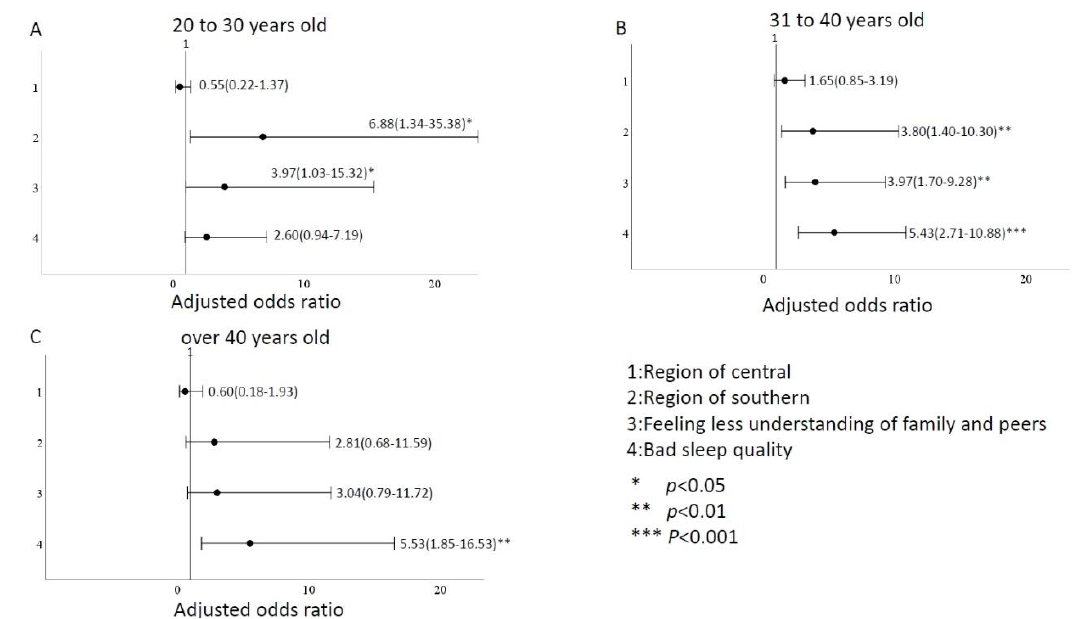
Figure 4. Comparison of odds ratio factors for stress levels in different ages. ( A ) between 20 – 30 years old ( B ) between 31 – 40 years old ( C ) over 40 years old.